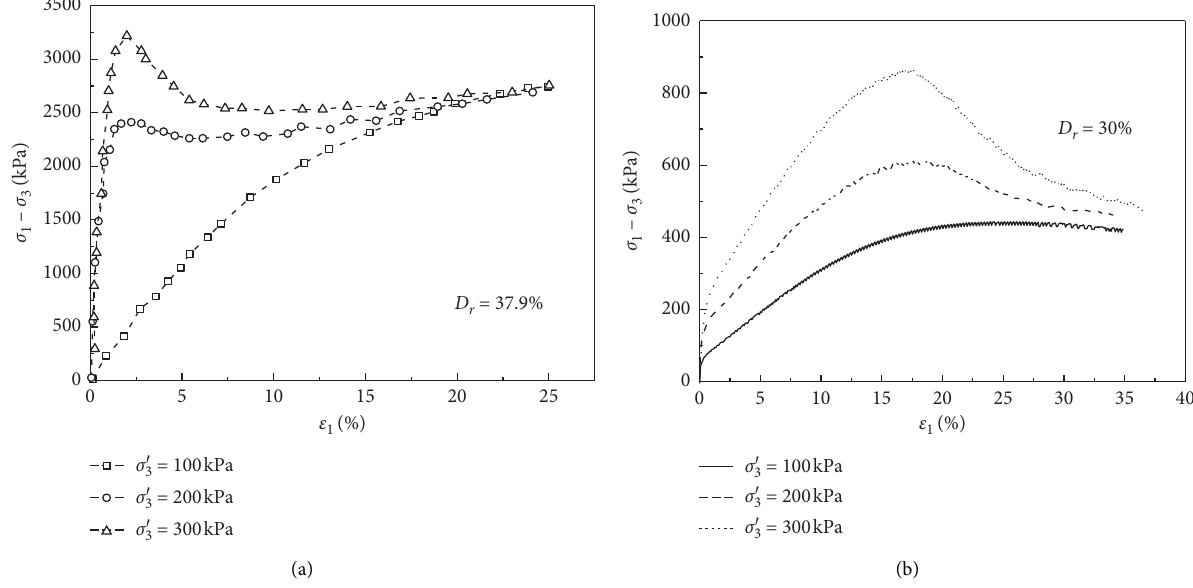
Figure 8: Stress-strain curves of sand at undrained compression. (a) Calcareous sand. (b) Toyoura sand (data from